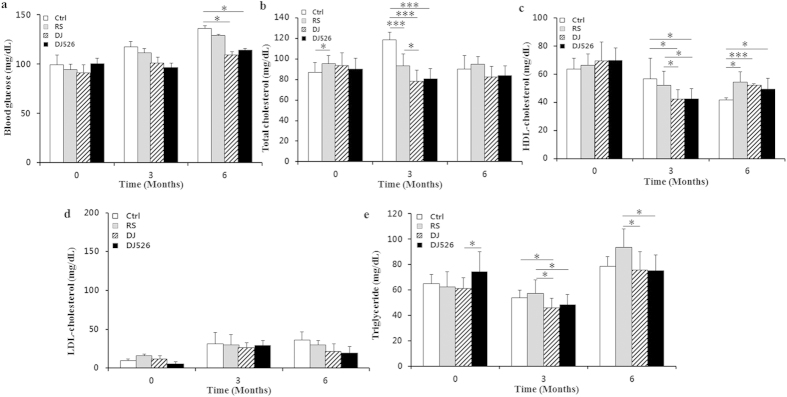
The effects of the resveratrol-enriched rice DJ526 on changes in blood with age progression.The control (Ctrl) mice fed a NFD in which the carbohydrate source was corn starch and sucrose; The resveratrol (RS) mice fed a NFD in which the carbohydrate source was corn starch and sucrose except containing resveratrol; Dongjin (DJ) mice fed a NFD in which the corn starch and sucrose were replaced with Dongjin rice; DJ526, mice fed a NFD in which the corn starch and sucrose were replaced with the resveratrol enriched rice DJ526. The resveratrol concentration in DJ526 and RS groups was 0.69 μg/g each, and not detected in Ctrl and DJ groups. Changes in Blood glucose levels (a), Total cholesterol levels (b), HDL-cholesterol levels (c), LDL-cholesterol levels (d) and Triglyceride levels (e) of mice during the 6 month experimental period. The values represent the mean ± s.d. (n = 20). Values in the figure with a superscripted letter indicate statistical significance as analyzed by an unpaired Student’s t-test; *p < 0.05, ***p < 0.001.